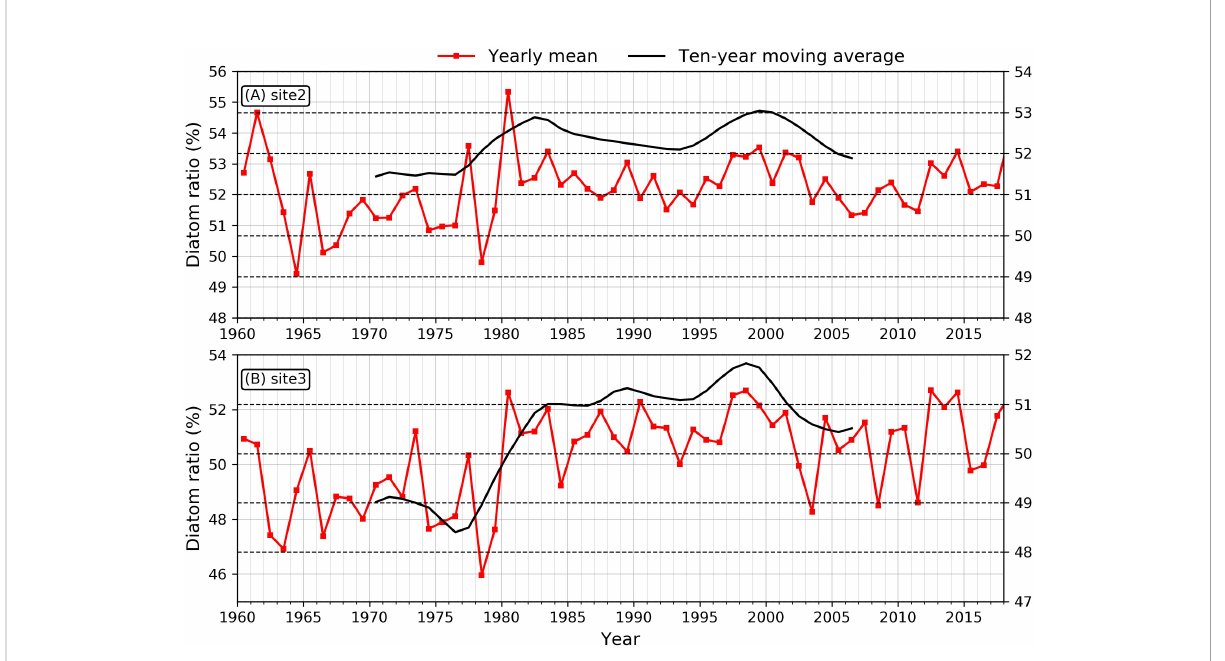
FIGURE 7 Time series of the diatoms proportion at (A) site 2 and (B) site 3. The black lines are ten-year fi